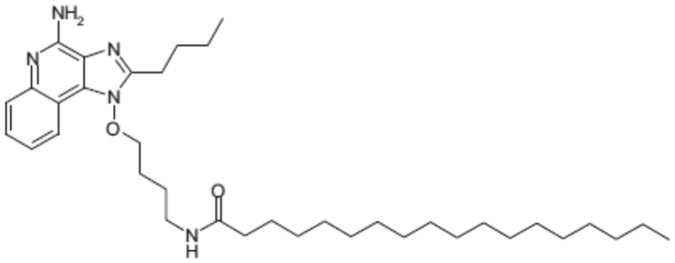
Chemical structure of 3M-052.